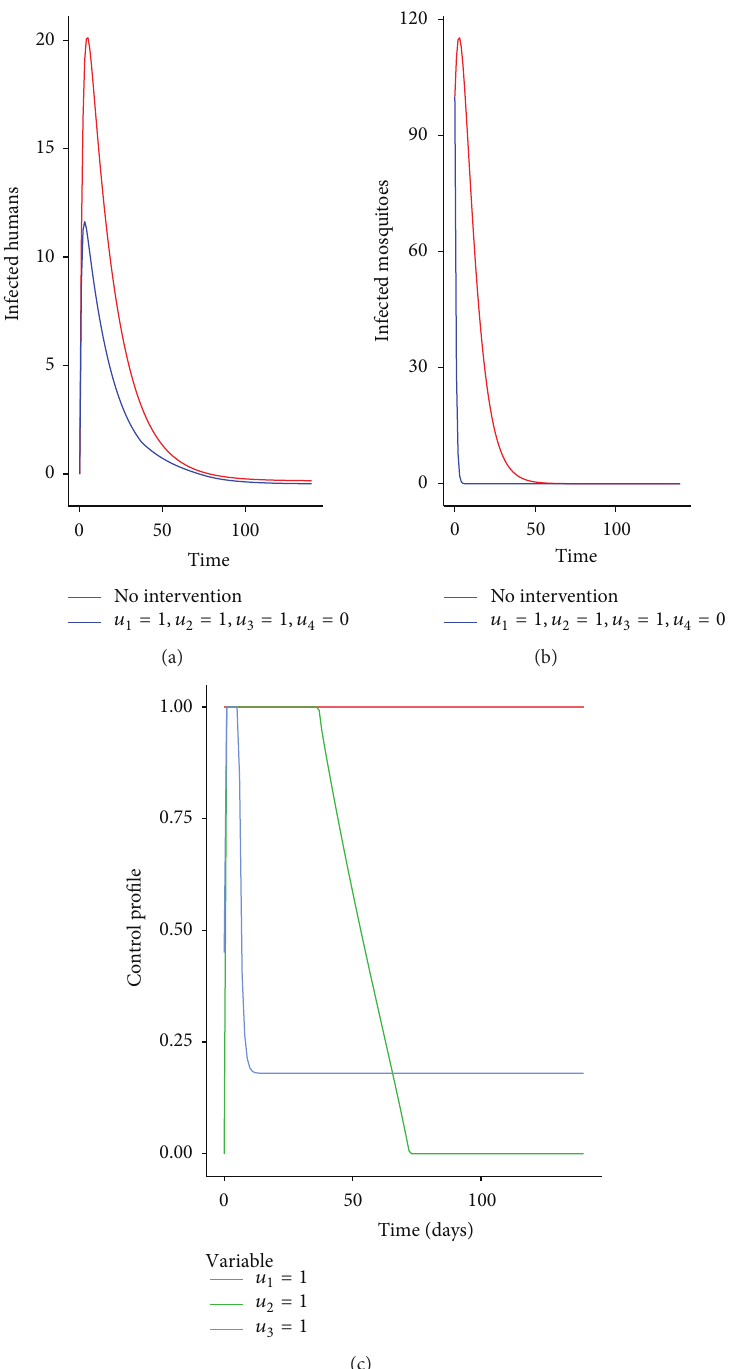
Figure 5: Simulations of the model showing the effect of ITNs, treatment, and IRS on the spread of malaria for the endemic setting.